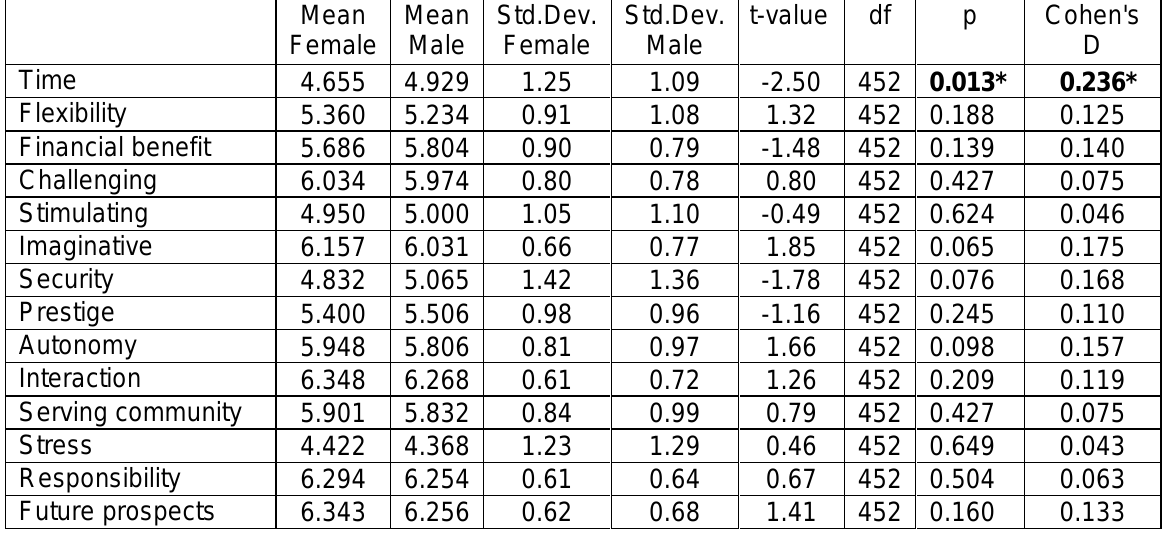
TABLE 4 GENDER OF STUDENTS AND WORK VALUES (MALE N = 254; FEMALE N =